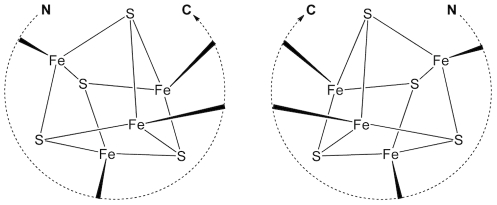
Two topological states of peptide-Fe4S4 cluster.